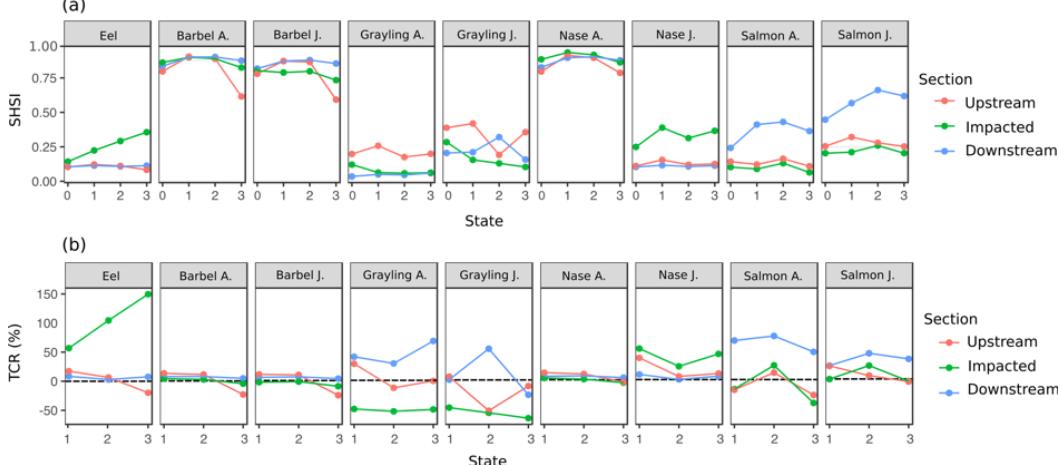
Figure 9. Temporal evolution of fish habitat suitability. ( a ) evolution of the SHSI for each species and section at each S i ; ( b ) diachronic TCR (%) for each species and section at each S i compared to the value calculated at S 0 . A. and J. correspond to adult and juvenile life stages,